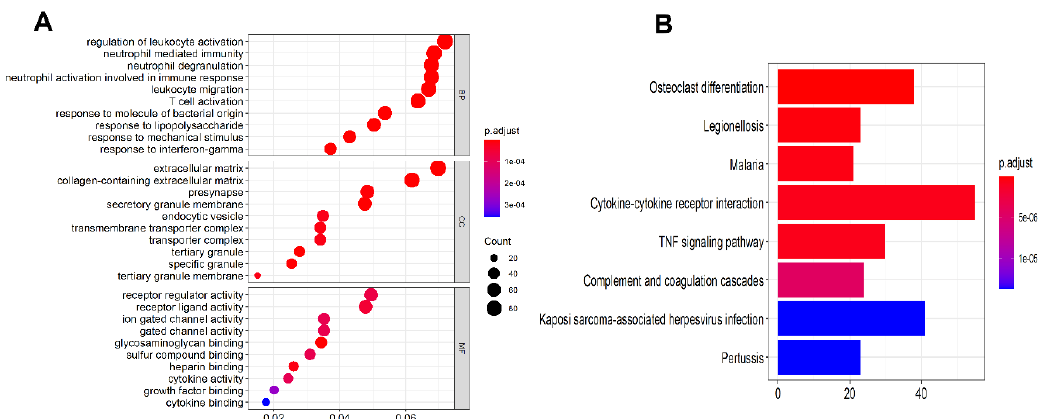
Figure 3. ( A ) Dot plot showing the Gene Ontology (biological process, cellular process, molecular function) analysis for the differentially expressed genes (DEGs) identified in the meta-analysis. Dots are color-coded from blue to red based on the adjusted p -value. The size of the dots is proportional to gene count. ( B ) Bar plot shows KEGG molecular pathways enriched by the DEGs ( p -value <0.05). Bars are color-coded from blue to red based on the adjusted p -value.